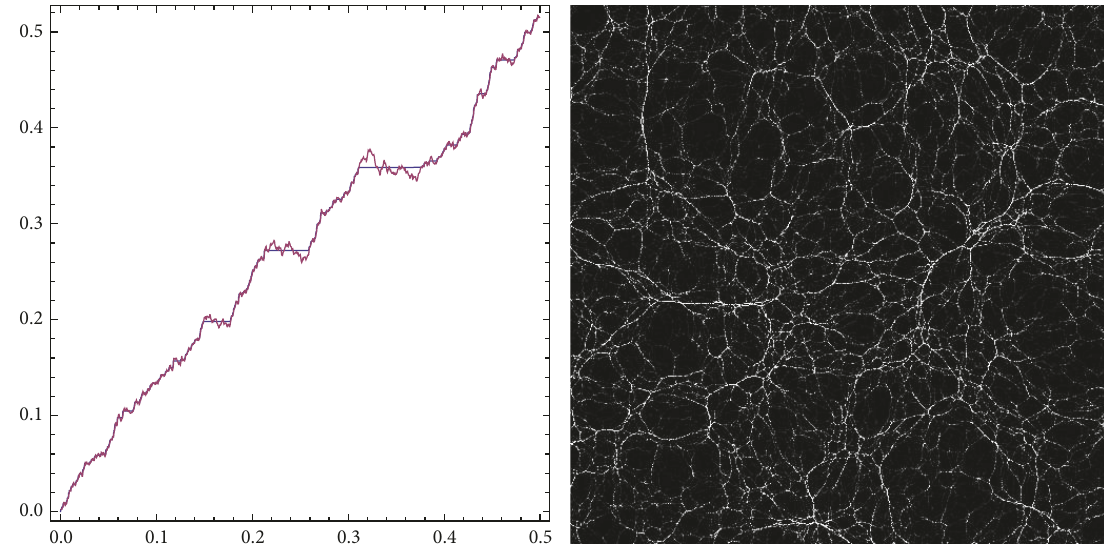
Figure 1: Realizations in oneor two dimensions of the exact solution of theadhesion model with scale-invariant initial velocity field ( ℎ = 1/2 ). In both, the length scale is arbitrary, due to the self-similarity, so that the relevant scale is the scale of the largest structures. Left-hand side: in one dimension, Lagrangian map from initial to final positions, with multistreaming, and devil’s staircase formed by mass sticking. Right-hand side: web structure of final positions in two